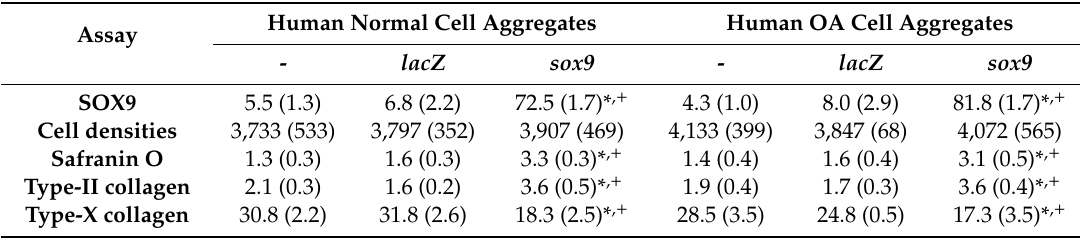
Table 1. Histomorphometric analyses in rAAV-transduced aggregate cultures of human normal and OA chondrocytes (day